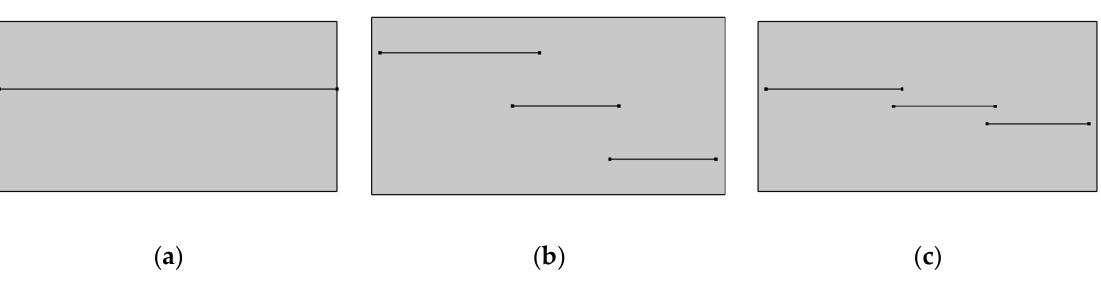
Figure 9. Schematic plot of the numerical model. ( a ) k = 0.51 mD; ( b ) k = 0.25 mD; ( c ) k = 0.35 mD.